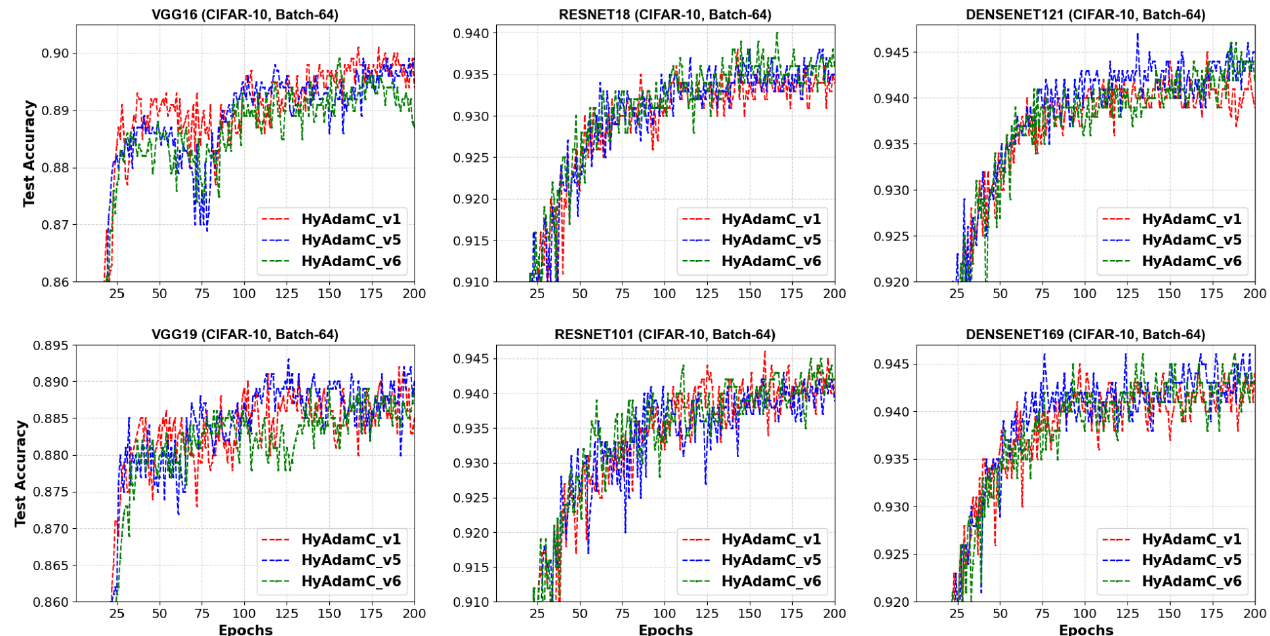
Figure 11. The test accuracy curves of VGG, ResNet, and DenseNet trained by HyAdamC-v1, v5, and v6 with CIFAR-10 images in the 64-batched